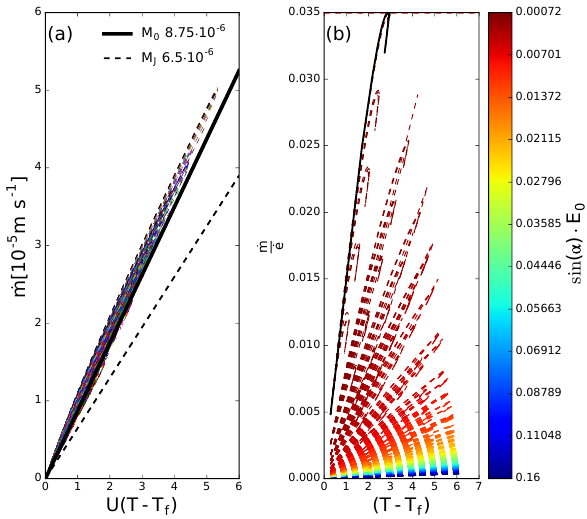
Figure A1. Investigation of melting proportion in the plume equa- tions for different LP experiments. The plume model was run in a well-mixed environment for different parameter settings: E 0 [0.036–0.16], sin (α) [0.02–1], q sg [10 − 5 –0.1m 2 s − 1 ], T a ] [0– 4 ◦ C. Panel (a) shows the melt rate as a function of plume ve- locity U and plume temperature T and its freezing temperature T f ( ˙ m = M 0 (T − T f )U ). The average slope of the run is M 0 ≈ 8 . 75 × 10 − 6 (thick black line) while for the simplified equations of Jenkins (2011) a typical slope lies of the order of 6 . 5 × 10 − 6 (black dashed line). The second panel illustrates that ˙ m (cid:28) ˙ e in this parameter range, but ˙ m/ ˙ e being largest for long floating